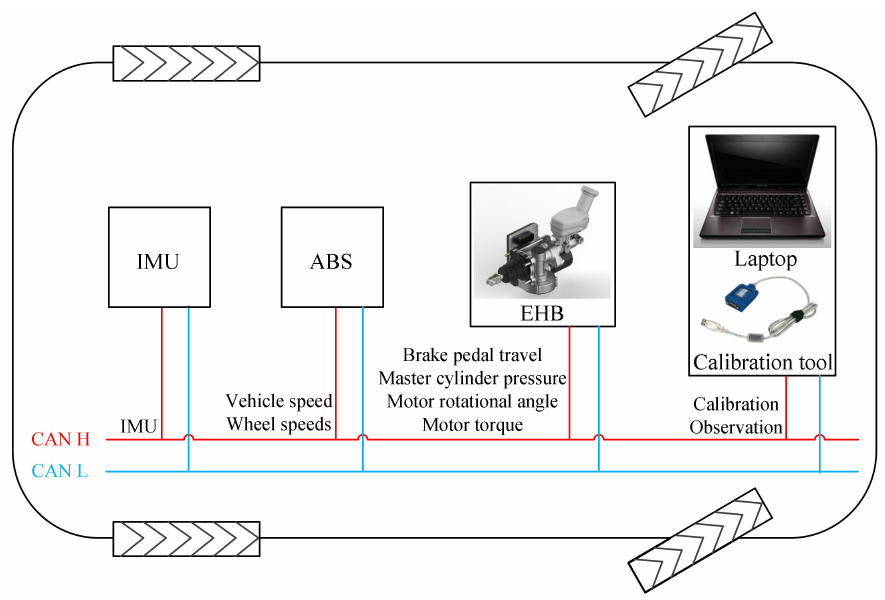
Figure 3. Scheme of the vehicle platform.